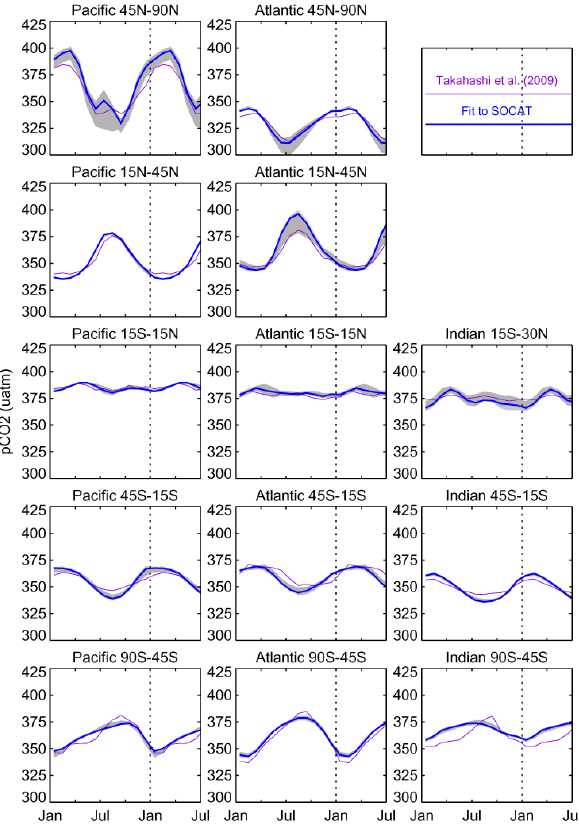
Fig. 7. Analogously to Fig. 6, monthly mean seasonal cycle of surface-ocean carbon dioxide partial pressure p CO 2 m , estimated by fitting the diagnostic scheme to SOCAT data (run SFC , blue). The grey shading comprises the same sensitivity cases. For comparison, the p CO 2 m climatology by Takahashi et al. (2009) is given (violet, with a small additive adjustment to transfer the nominal year 2000 average into a 1997–2009 average according to the rising atmo- spheric CO 2 partial pressure field p CO 2 a , Eq.